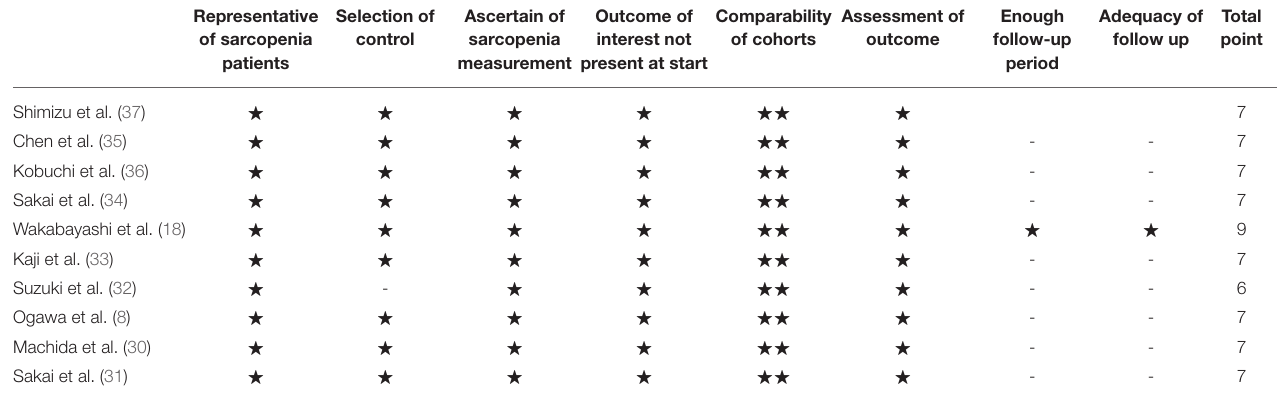
TABLE 3 | Quality assessment for the included studies by using the newcastle-ottawa scale.